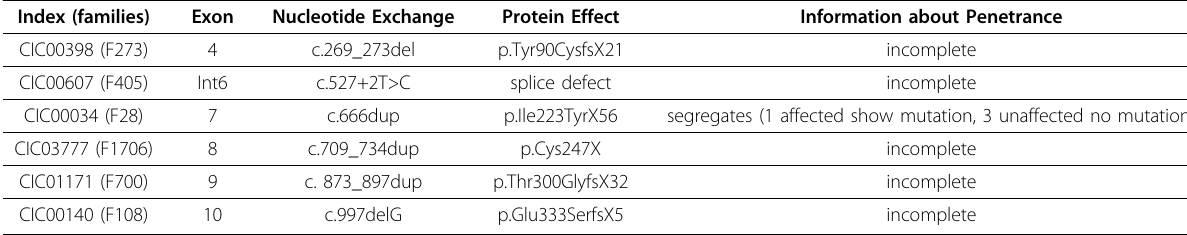
Table 2 Novel PRPF31 mutations in a French adRP